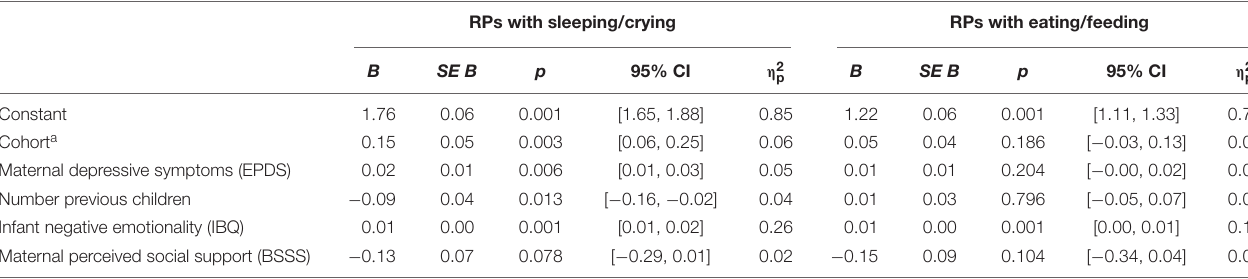
TABLE 4 | Main effects for the associations of infant RPs with the included variables ( n = 162). RPs with sleeping/crying RPs with